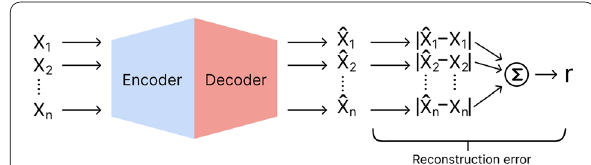
Fig. 4 The procedure of calculation RE in existing AE-based anomaly detection methods